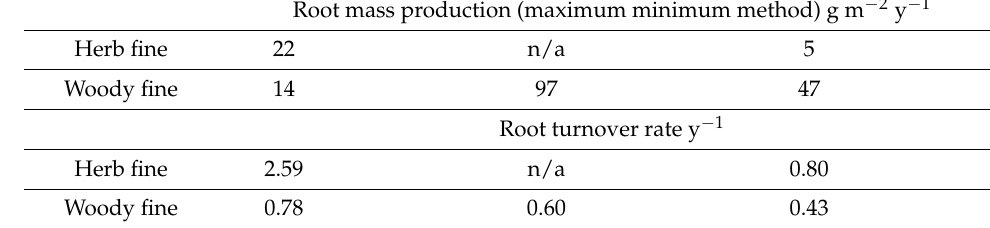
Table 2. Mean root biomass and root length in 16-, 22-, and 45-year-old post-mining sites ± SEM, based on all sampling occasions ( n = 24 for each site) in the whole soil profile measured. Root pro- duction was estimated by the maximum–minimum method, and root turnover was calculated as production divided by mean biomass. Statistically homogeneous groups of sites are marked by the same letter (one-way ANOVA, LSD post hoc test). Root